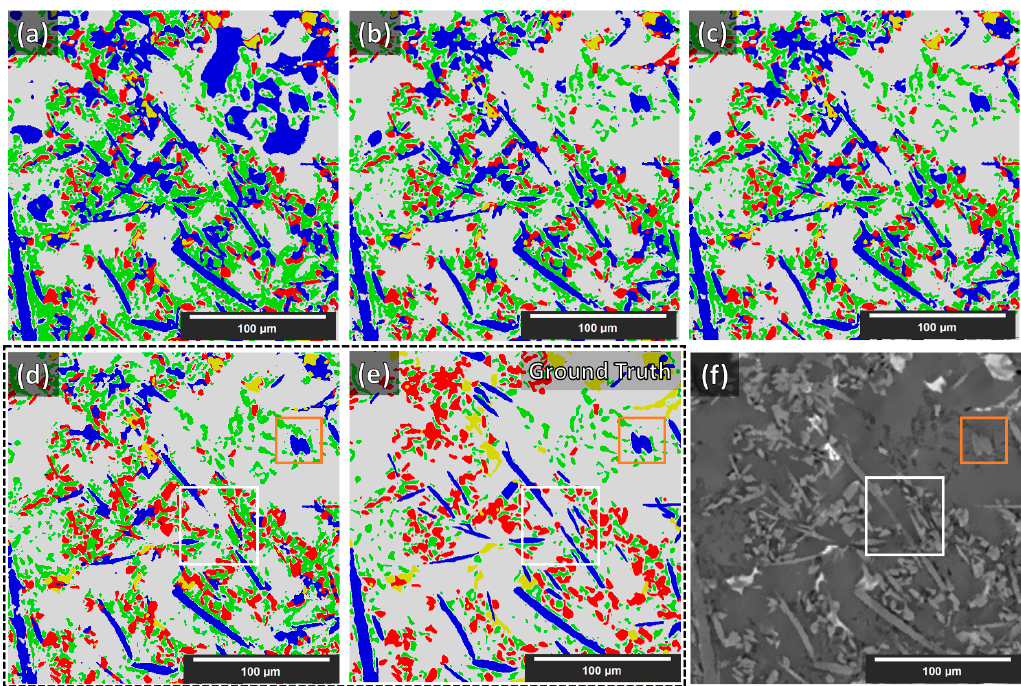
Figure 8. Segmentation results of the experimental NLM-conditioned AlSi12CuMgNi MMC XCT data for all examined cases. Images ( a )–( d ): cases 1–4 above, respectively. Images ( e ) and ( f ): manual labels (ground truth) and the respective slice from the XCT reconstruction volume, respectively. Labels → blue—fibers; yellow—IMs; green—Si; red—SiC particles; gray—Al matrix. The white and orange squares are regions of interest described in the text below.